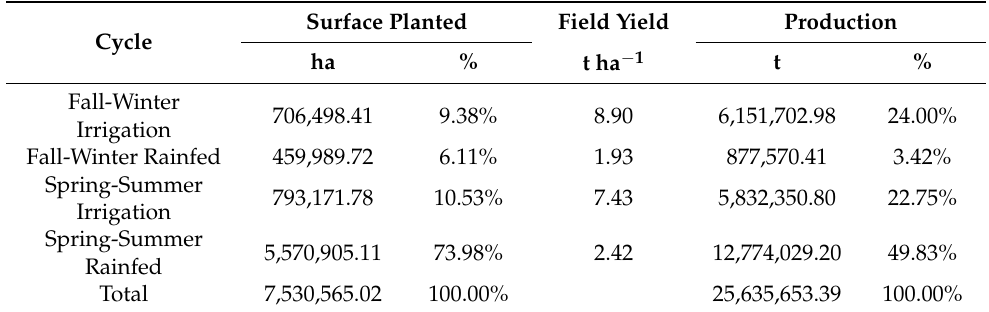
Table 3. Average of field indicators for grain maize production in Mexico per production cycle and water regime from 2013 to